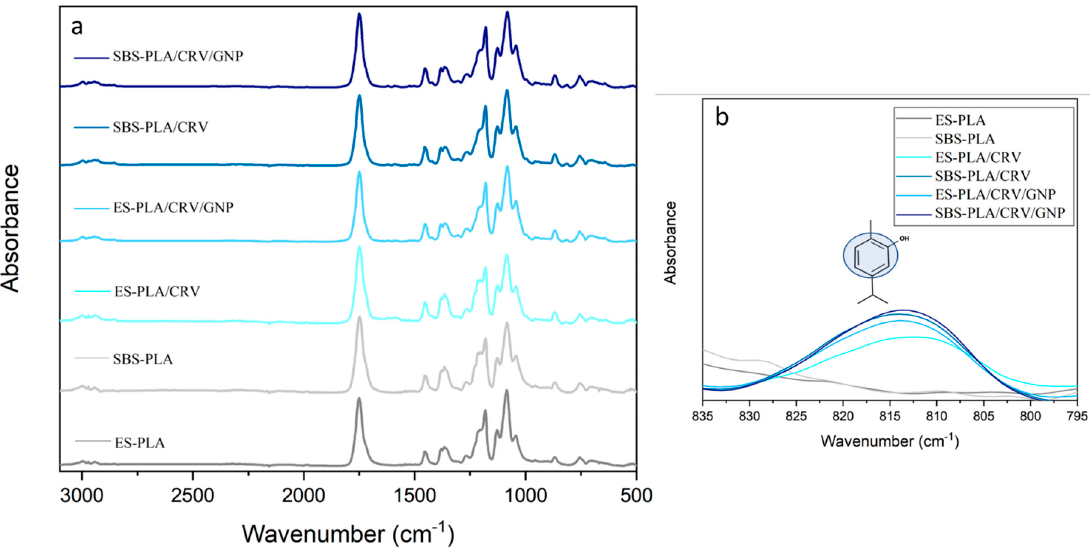
Figure 5. ATR-FTIR spectra of the CRV fibrous membranes ( a ) and a close-up of spectral range: 835–795 cm − 1 , relative to the peak at 1084/1091 cm − 1 of CRV aromatic ring ( b ).